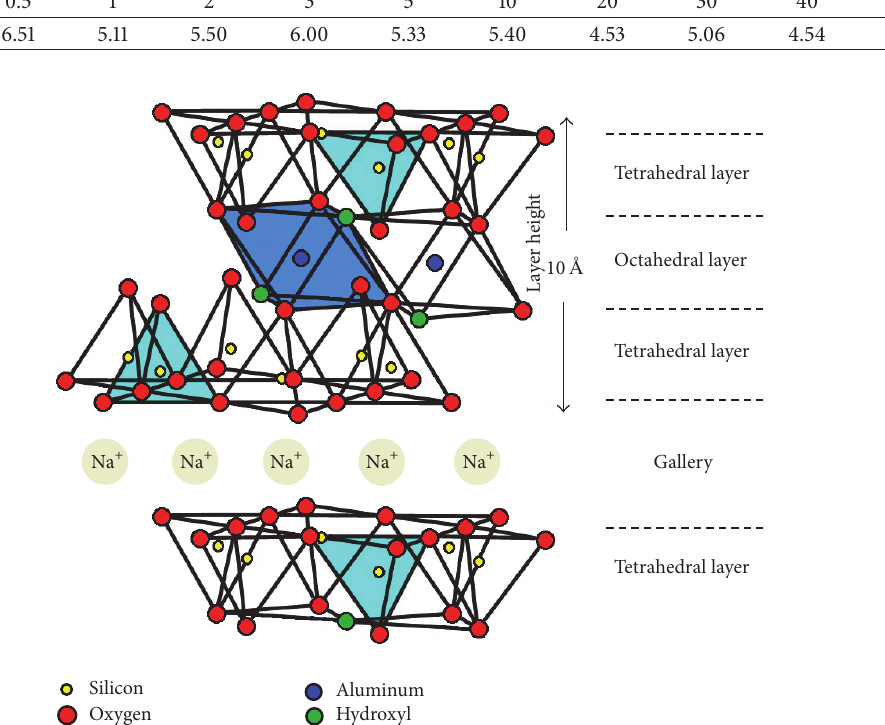
Figure 1: Schematic of the montmorillonite layered silicate platelet showing one platelet height and the gallery spacing between layers.